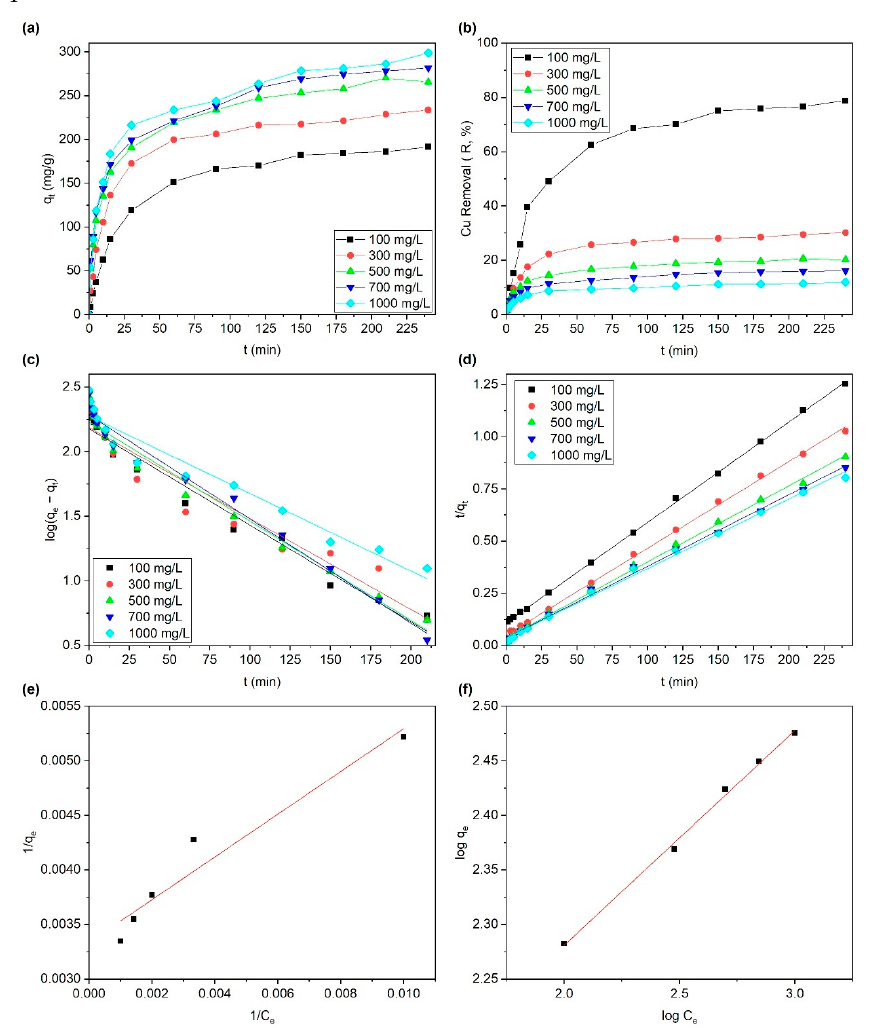
Figure 4. ( a ) qt and ( b ) Cu removal of 0.4 g/L of WGFCA in 100, 300, 500, 700, and 1000 mg/L Cu(II) concentration for 0–240 min; ( c ) PFO and ( d ) PSO kinetic model fittings; ( e ) Langmuir and ( f ) Freundlich isotherms.